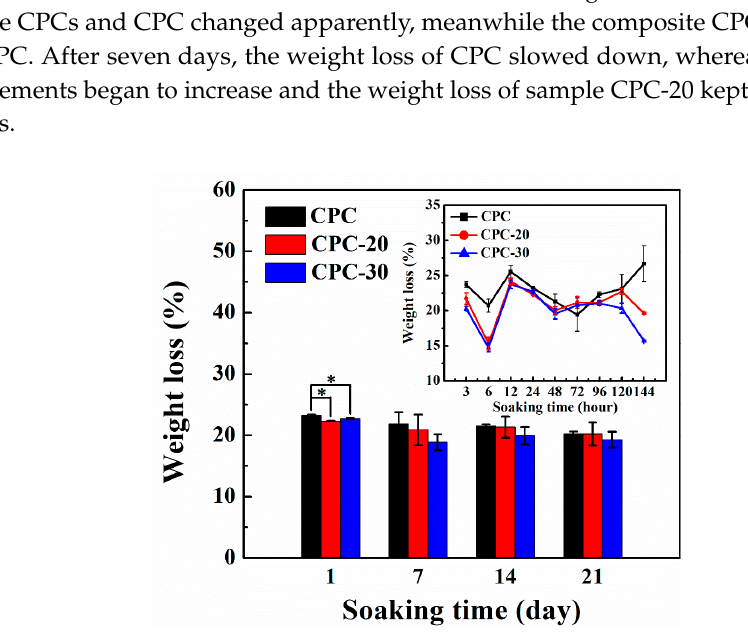
Figure 9. Change in pH value of SBF solution during PLGA-PEG-PLGA/CPCs degradation studies (n = 4). 3.8. Phase Composition Analysis Phase components of PLGA-PEG-PLGA/CPCs and CPC after soaking for three days were shown in Figure 10a,b. The major phases of all samples were carbonate-substituted hydroxyapatite (CHA, PDF#35-0180) and hydroxyapatite (HA, PDF#74-0565), while some residual TCP was also detected (PDF#09-0169). With the volume ratio of hydrogel increasing to 20% v / v , the relative intensity of HA peaks and CHA peaks increased whilst the intensity of TCP peaks decreased (Figure 10b). As the volume ratio of hydrogel continued to rise to 40% v / v (CPC-40), the relative intensity of CHA and HA weakened compared with other samples.